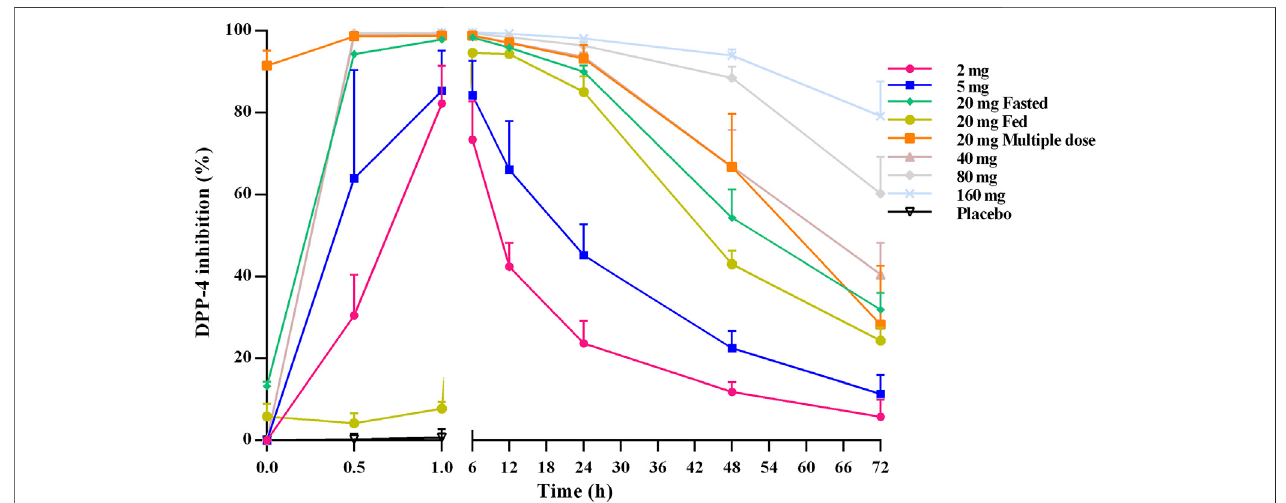
FIGURE 3 | Mean (SD) DPP-4 inhibition – time pro fi les after oral administration of TQ-F3083 at doses of 2 – 160 mg.